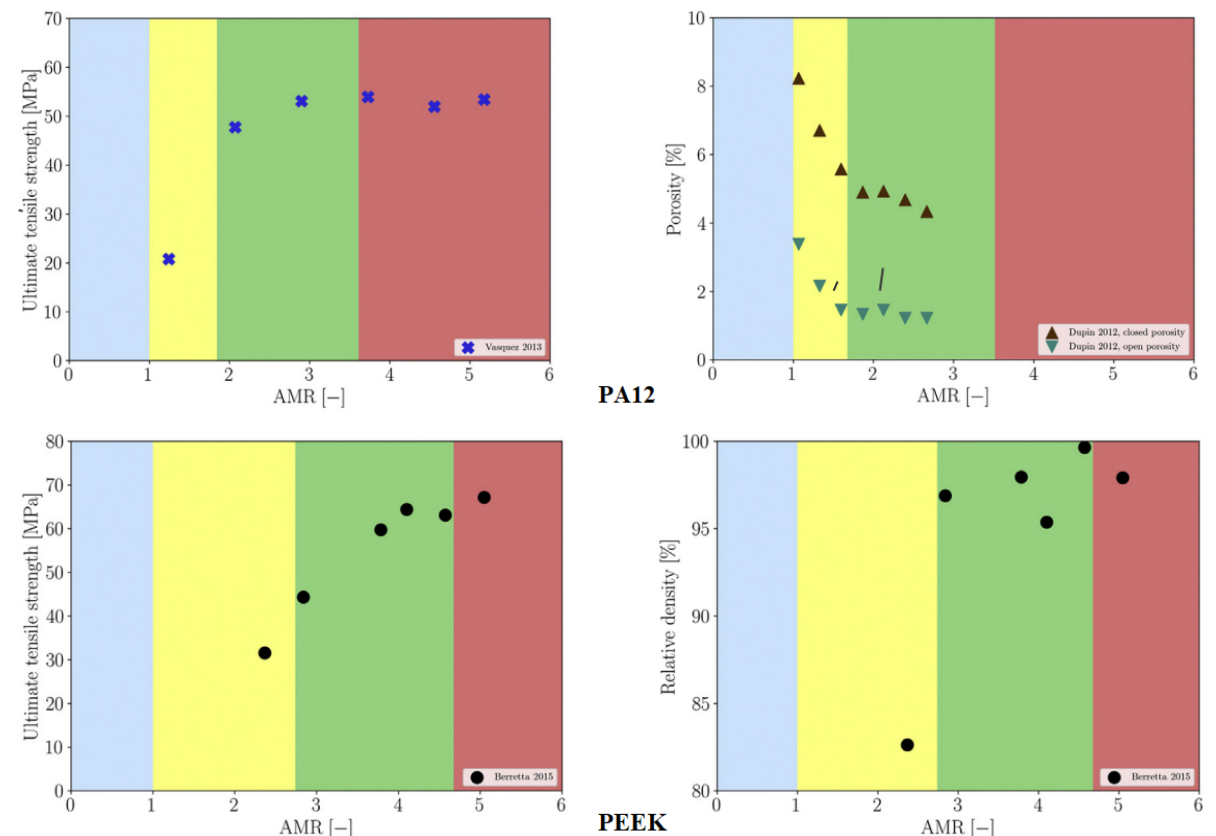
Figure 21. Laser-sintered PA12 and PEEK part properties as functions of the attenuation melt ratio (AMR) with color-coded process regimes (light blue: no melting; yellow: pool too shallow; green: process window; red: degradation) [152].